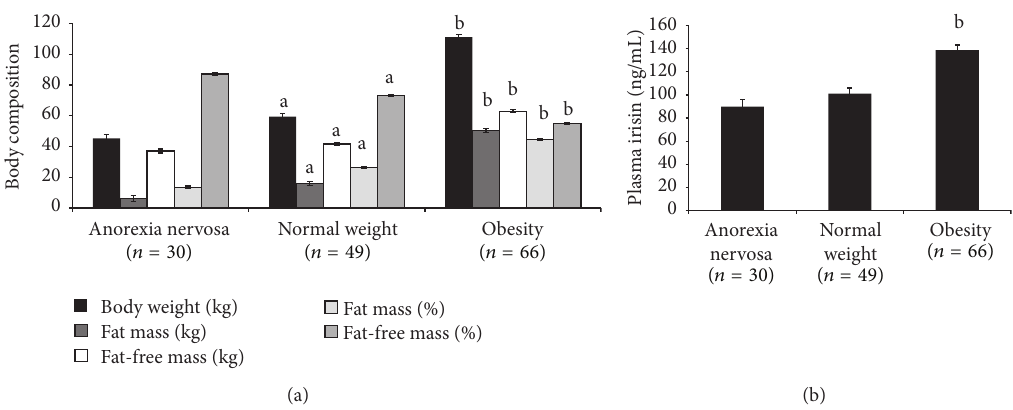
Figure 1: Body composition and plasma irisin circulating levels. Body weight (kg), fat mass (kg), fat-free mass (kg), fat mass (%), and fat-free mass (%) are shown in the anorexia nervosa, normal weight, and obese groups. (a) Plasma irisin concentration in the three experimental groups (b). The data are shown as the mean (SE). Statistically significant differences are denoted as (a) 𝑃 < 0.001 versus anorexia nervosa and (b) 𝑃 < 0.001 versus normal weight and anorexia nervosa.